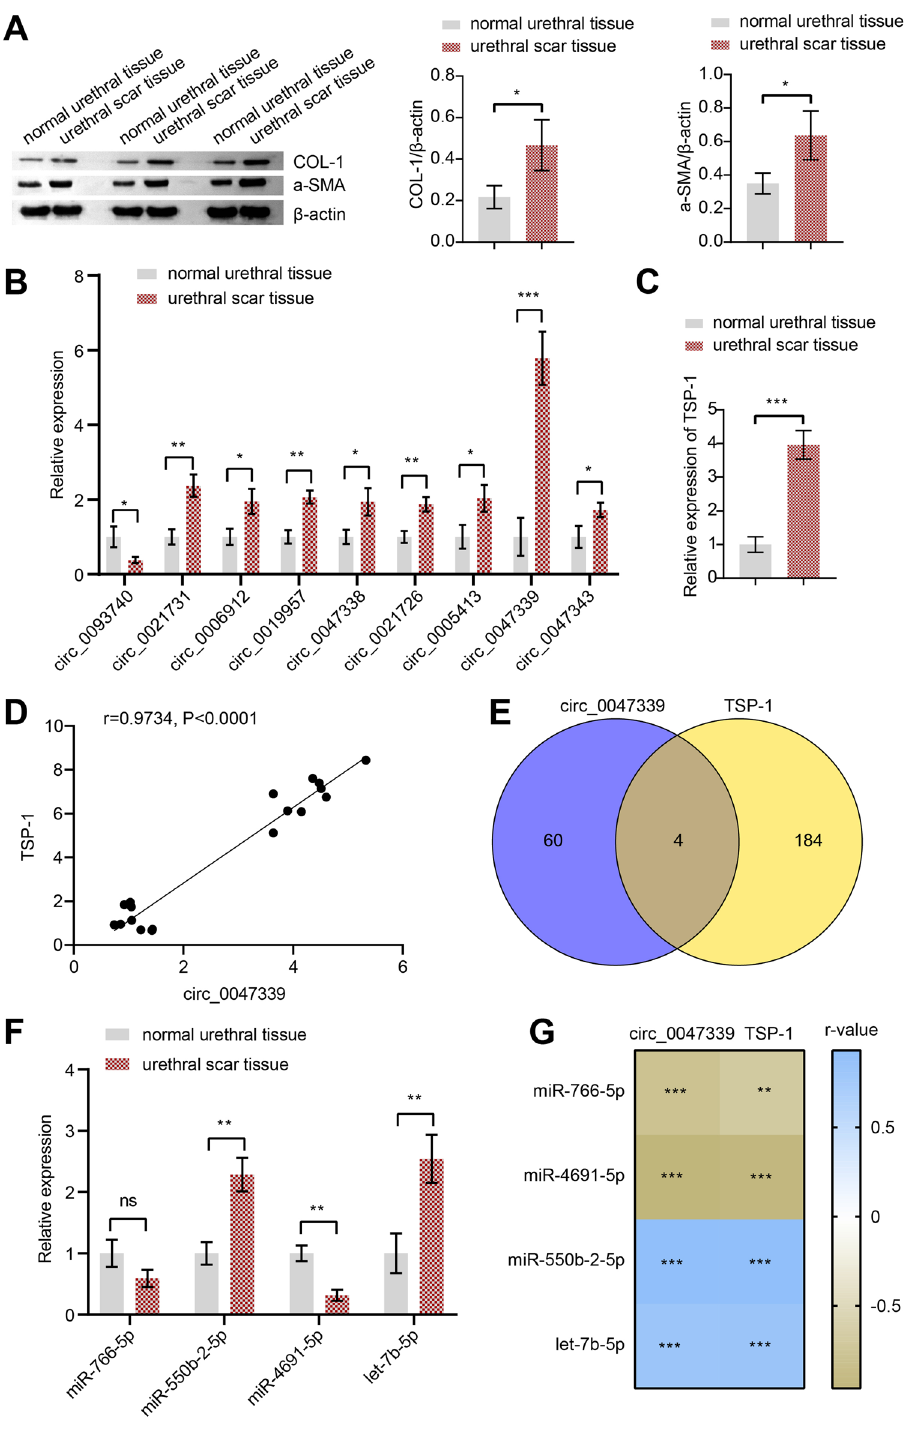
Figure 3. The expression of circ_0047339/miRNA/TSP-1 interaction in urethral scar tissue. ( A ) We performed western blot to verify the expression of COL-1 and α-SMA in urethral scar tissue. ( B ) We confirmed the expression of the first nine differential circRNA in the chip microarray analysis by RT-qPCR. ( C ) The expression of TSP-1 in urethral scar tissue was verified by RT-qPCR. ( D ) The correlation between TSP-1 and circ_0047339. ( E ) Venn diagram. ( F ) The expression of let-7b-5p, miR-4691-5p, miR-766-5p and miR-550b-2-5p were characterized by RT-qPCR in urethral scar tissue. ( G ) Correlation analysis of TSP-1 and circ_0047339 with let-7b-5p, miR-4691-5p, miR-766-5p and miR-550b-2-5p. Blue represents positive correlation, and brown represents negative correlation. A larger absolute value of the r-value indicates a stronger correlation. *P < 0.05, **P < 0.01, ***P < 0.001, ns no